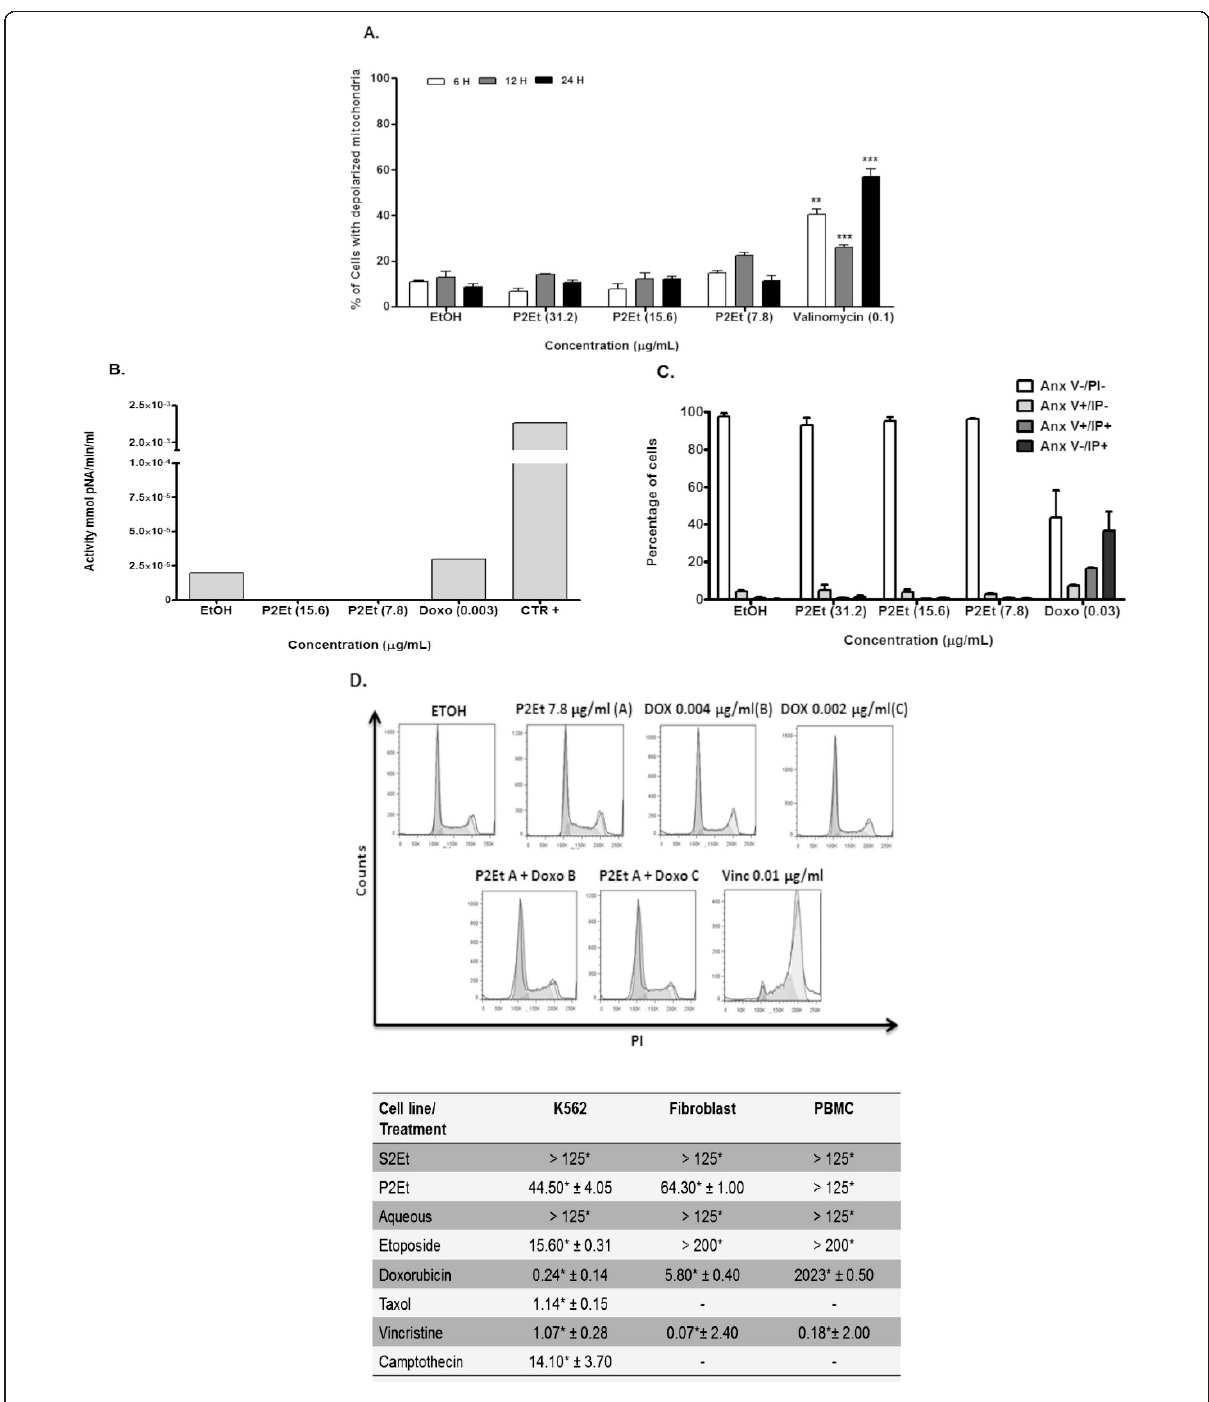
Figure 6 Induction of G1 cell cycle arrest but not apoptotic cell death in MCF7 cells by the P2Et fraction . (A) MCF7 cells treated with the P2Et fraction for 6, 12 or 24 h, stained with JC-1 and analyzed by flow cytometry. Ethanol was used as negative and valinomycin as positive controls (*** p < 0.001). (B) Caspase 3 activity was measured using the ELISA assay after cells had been treated with the P2Et fraction or doxorubicin (positive control) for 48 h (** p < 0.005). (C) PS externalization was estimated in MCF7 cells using flow cytometry after treatment with the P2Et fraction, doxorubicin (positive control) or ethanol (negative control) for 48 h. (D) Cell cycle analysis was performed on MCF7 cells treated with ethanol (negative control), the P2Et fraction (7.80 μ g/ml (A)), doxorubicin (0.004 μ g/ml (B) or 0.002 μ g/ml (C)), the P2Et fraction (A) + doxorubicin (B or C) and vincristine (0.01 μ g/ml, positive control) for 24 h. The cells were permeabilized, stained with propidium iodide (PI), acquired on a FACSAria I and analyzed with FLowJo software. Histograms represent relative cell DNA content measured in three independent